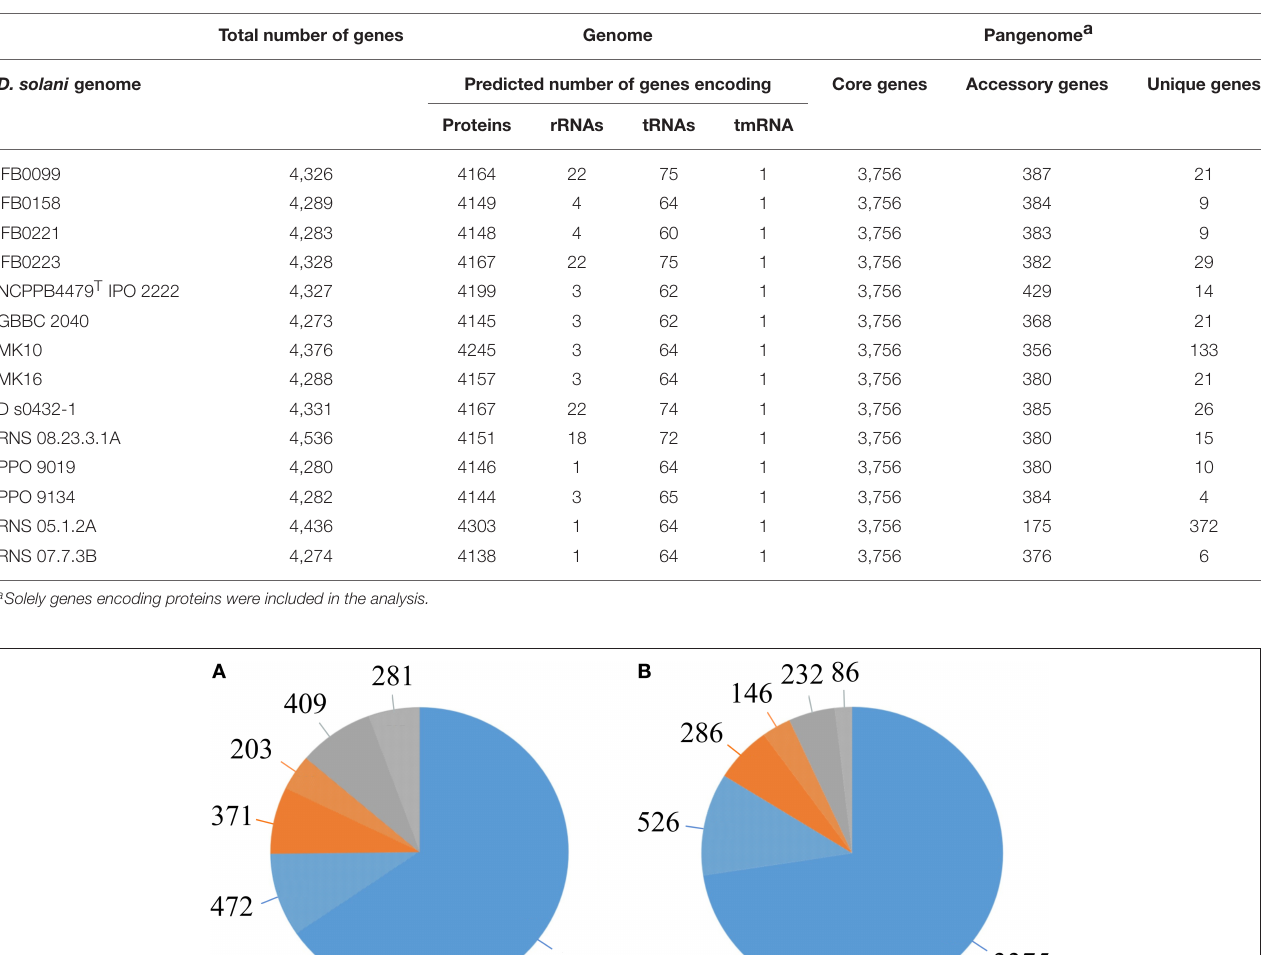
TABLE 2 | Genome and pangenome contents of D. solani strains.